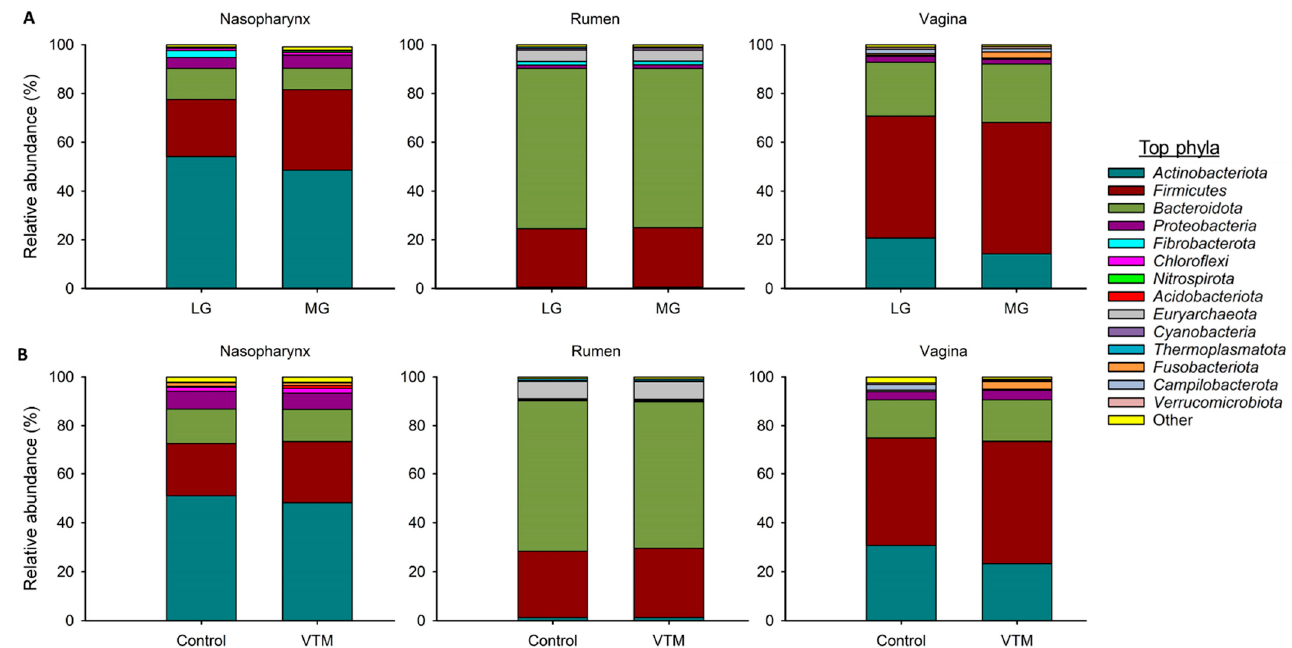
Figure 3. Percent relative abundance of the eight most relatively abundant phyla in the nasopharyngeal, ruminal and vaginal microbiota of ( A ) virgin yearling heifers from low gain (LG) or moderate gain (MG) dams and ( B ) pregnant heifers that received a vitamin and mineral supplement (VTM) or a control diet (Control) during the first 6 six months of gestation. Table 3. Percent relative abundance of the 42 most relatively abundant genera in nasopharyngeal ( n = 29), ruminal ( n = 26) and vaginal ( n = 27) microbiota of received diets without (CON) and with vitamin and mineral supplementation (VTM) during the first 6 months of gestation 1 .